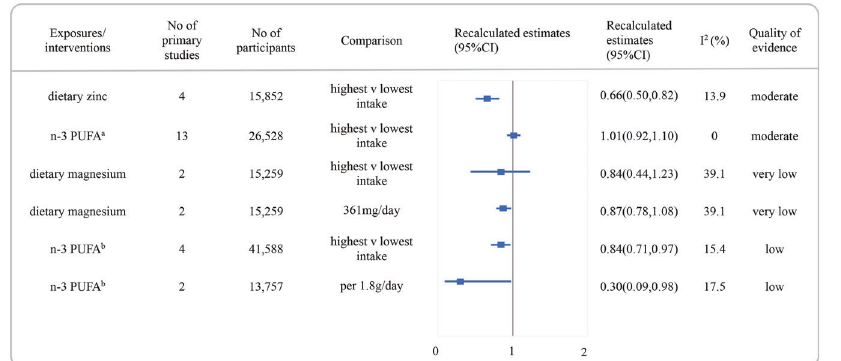
Fig. 4 Summary estimates with 95% con fi dence intervals and quality of evidence for the associations between nutrients and the risk of depression. a Based on meta-analysis of randomized clinical trials, b based on meta-analysis of cohorts. n-3 PUFA omega-3 poly-unsaturated fatty acid, CI con fi dence